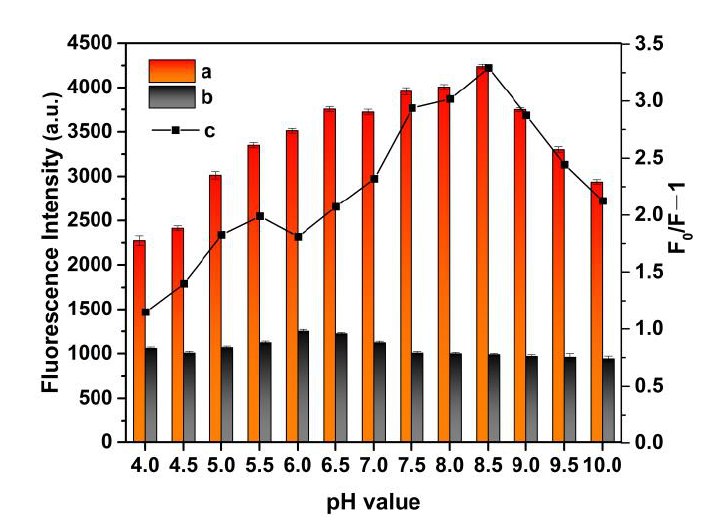
Figure 6. pH influence on the fluorescence intensity of MIP@QDs ’ a absence and b in the presence of SAM. c Fluorescence quenching degree of the MIP@QDs. Experimental condition: buffer solution (pH 4.0 – 10.0, 0.02 mol L −1 ) and room temperature.